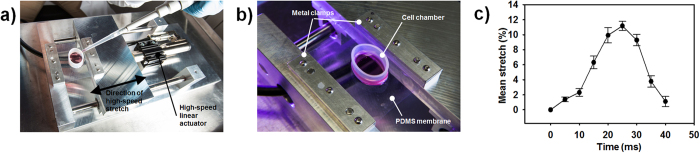
In vitro mTBI bioreactor.(a) mTBI bioreactor. (b) Stretchable cell chamber within mTBI bioreactor. (c) Actual mean temporal stretch waveforms within the cell chamber for each mTBI injury cycle.